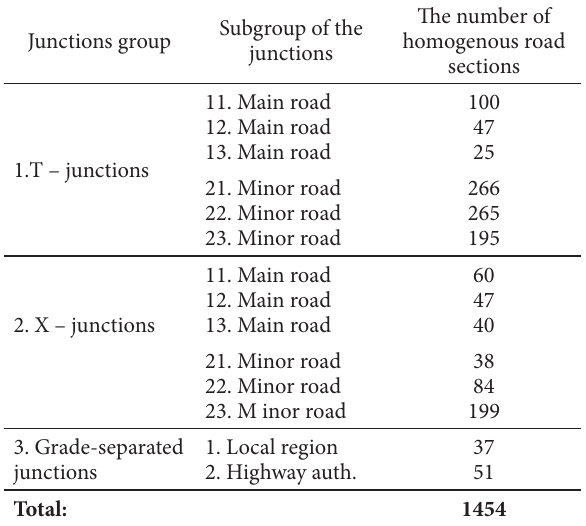
Table 3. The number of homogenous sections of junctions